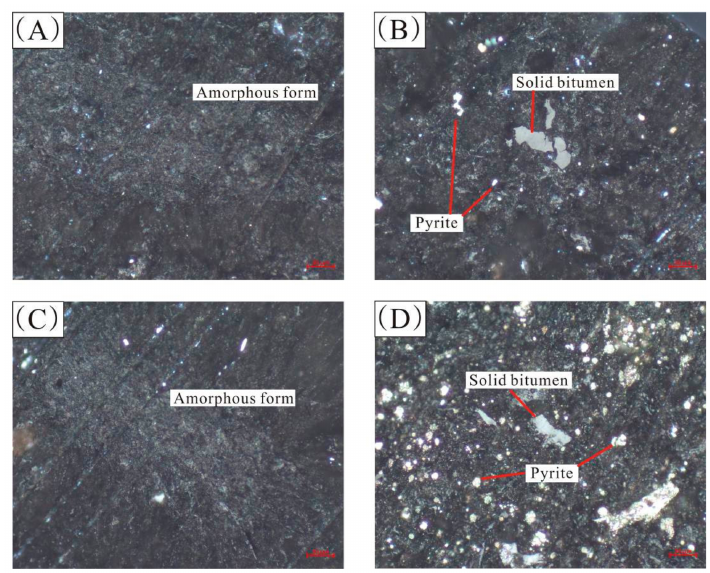
Figure 4. Photos of maceral examination. ( A ) PMZ001; ( B ) PMH008; ( C ) PMD005; and ( D ) PML003. ( A , B ) Niutitang Formation; and ( C , D ) Longmaxi